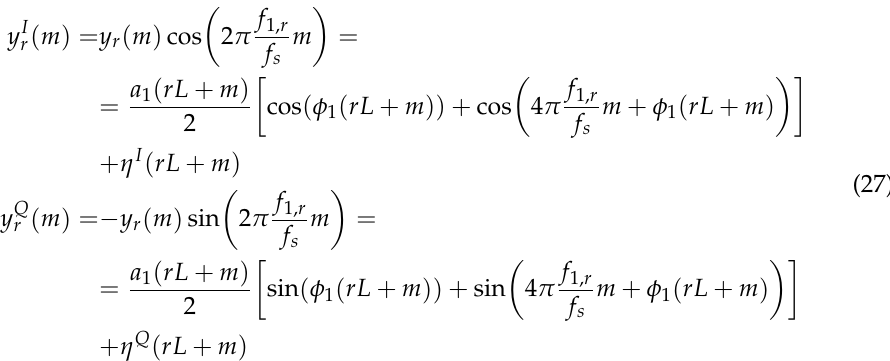
Table 2. Steps of the tuned real-valued TWLS estimation algorithm for